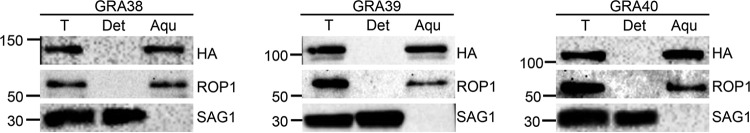
Triton X-114 fractionation of GRAs 38, 39, and 40. Triton X-114 (T) phase partitioning shows that GRA38, GRA39, and GRA40 are preferentially found in the aqueous (Aqu [soluble]) phase with the soluble marker ROP1, whereas the glycosylphosphatidylinositol (GPI)-anchored SAG1 remained in the detergent (Det [membrane]) fraction. Detergent lysis and fractionation were performed on intracellular parasites.